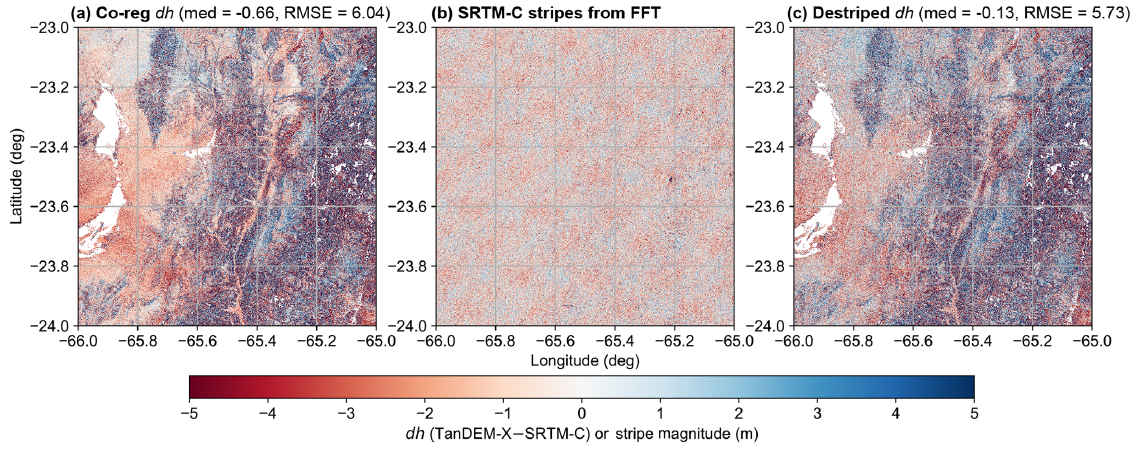
Figure 3. One iteration of FFT destriping from one tile (24 ◦ S, 66 ◦ W). Both median and RMSE improve from (a) the co-registered map to (c) the destriped map. Stripes removed by FFT are shown in (b) . Note that (c) is not the final corrected map as the iteration was run twice more before RMSE began to converge at a 5% tolerance level. Voids (white space) are untrustworthy pixels removed by TanDEM-X WAM cutoff prior to